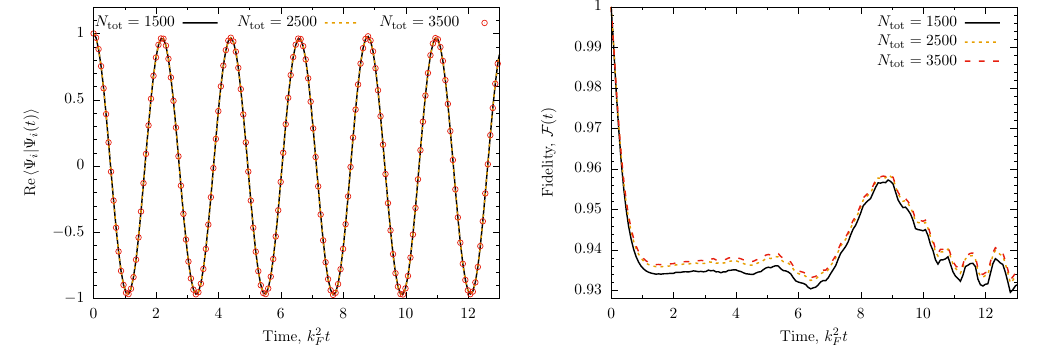
Figure 12: The real part of the return amplitude (23) (left) and the fidelity (25) = 20 → c = 10 in the Lieb-Liniger model, start- (right) following the quench c i f ing from the c ground state with N = 10 particles at unit density, N / R = 1. i = π ( N − 1 ) / R is the Fermi wave vector in the c = ∞ limit.) In both cases, ( k F we show the time evolution for three sizes of the truncated Hamiltonian (a matrix of × N size N ). Both these quantities rapidly converge with the number of states, tot tot see the convergence of the initial state energy for comparison in Fig.